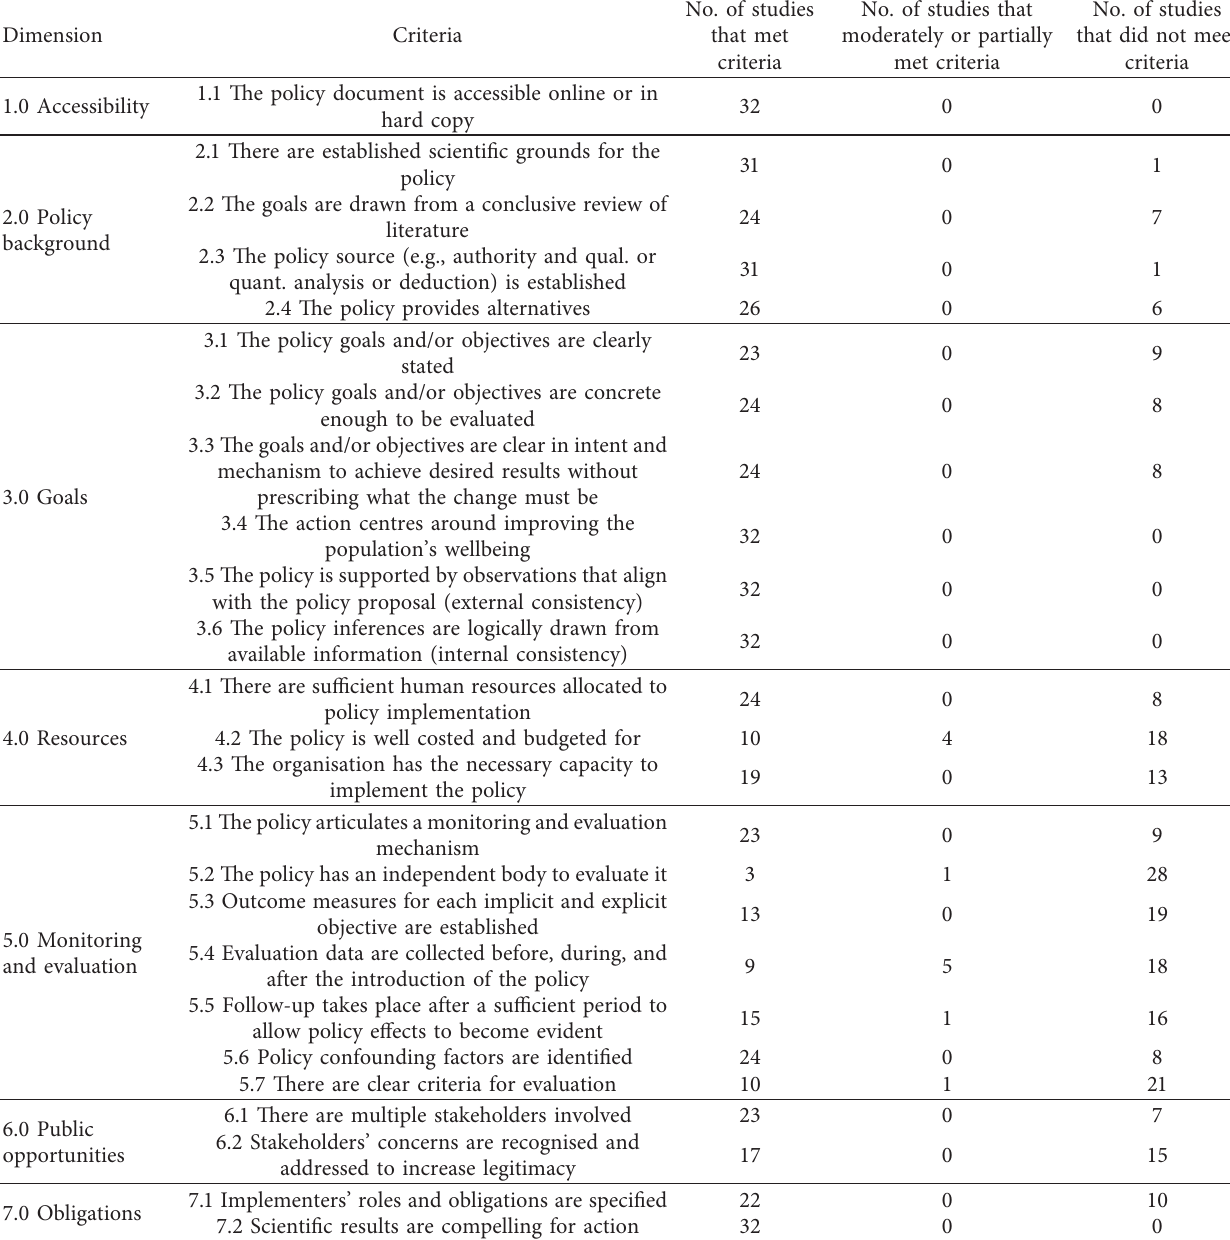
Table 4: Summary of quality assessment of policy documents based on logic of events framework.